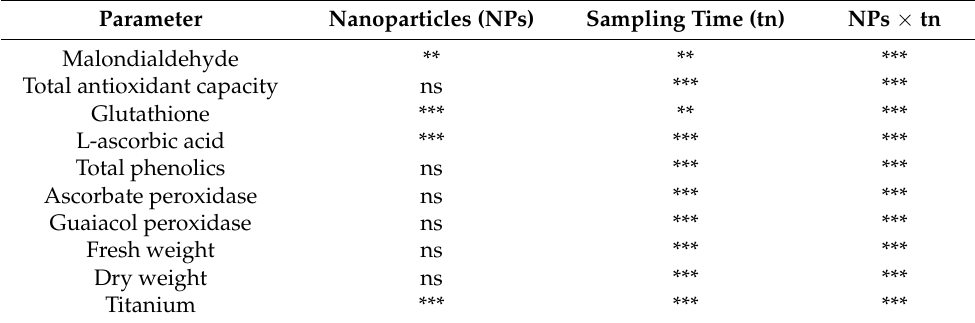
Table 1. ANOVA results for estimated parameters of oakleaf lettuce seedlings treated with TiO 2 -NPs as influenced by nanoparticles (NPs), sampling time (tn), and the interaction NPs × tn. Parameter Nanoparticles (NPs) Sampling Time (tn) NPs × tn Malondialdehyde ** ** *** Total antioxidant capacity ns *** *** Glutathione *** ** *** L-ascorbic acid *** *** *** Total phenolics ns *** *** Ascorbate peroxidase ns *** *** Guaiacol peroxidase ns *** *** Fresh weight ns *** *** Dry weight ns *** *** Titanium *** ***